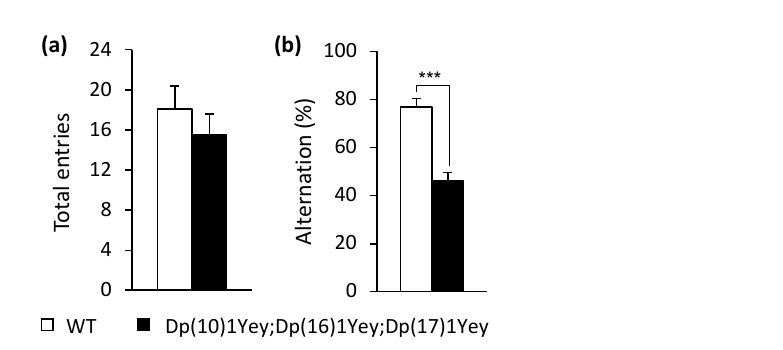
trol mice. ( c ) A representative picture of a nest built by a wild-type control mouse, which corresponded to a score of 4. ( d ) A representative picture of the Nestlet remaining in the cage of a Dp(10)1Yey;Dp(16)1Yey;Dp(17)1Yey mouse, which cor- responded to a score of 1. *, p < 0.05.